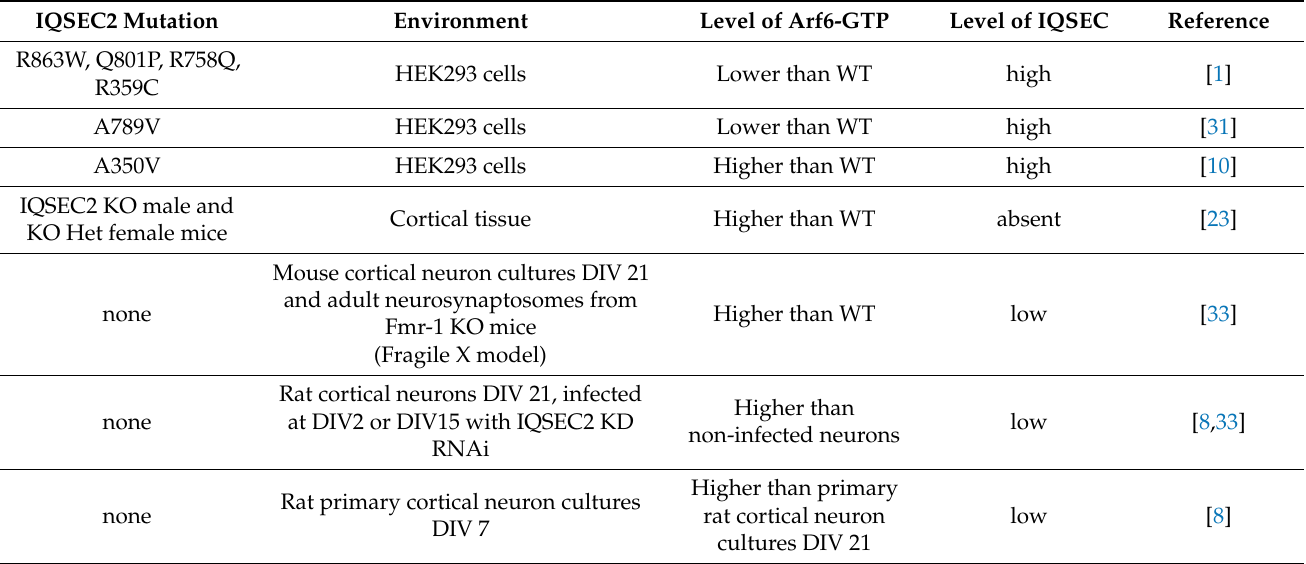
Table 1. Levels of Arf6-GTP as a function of IQSEC2 status and